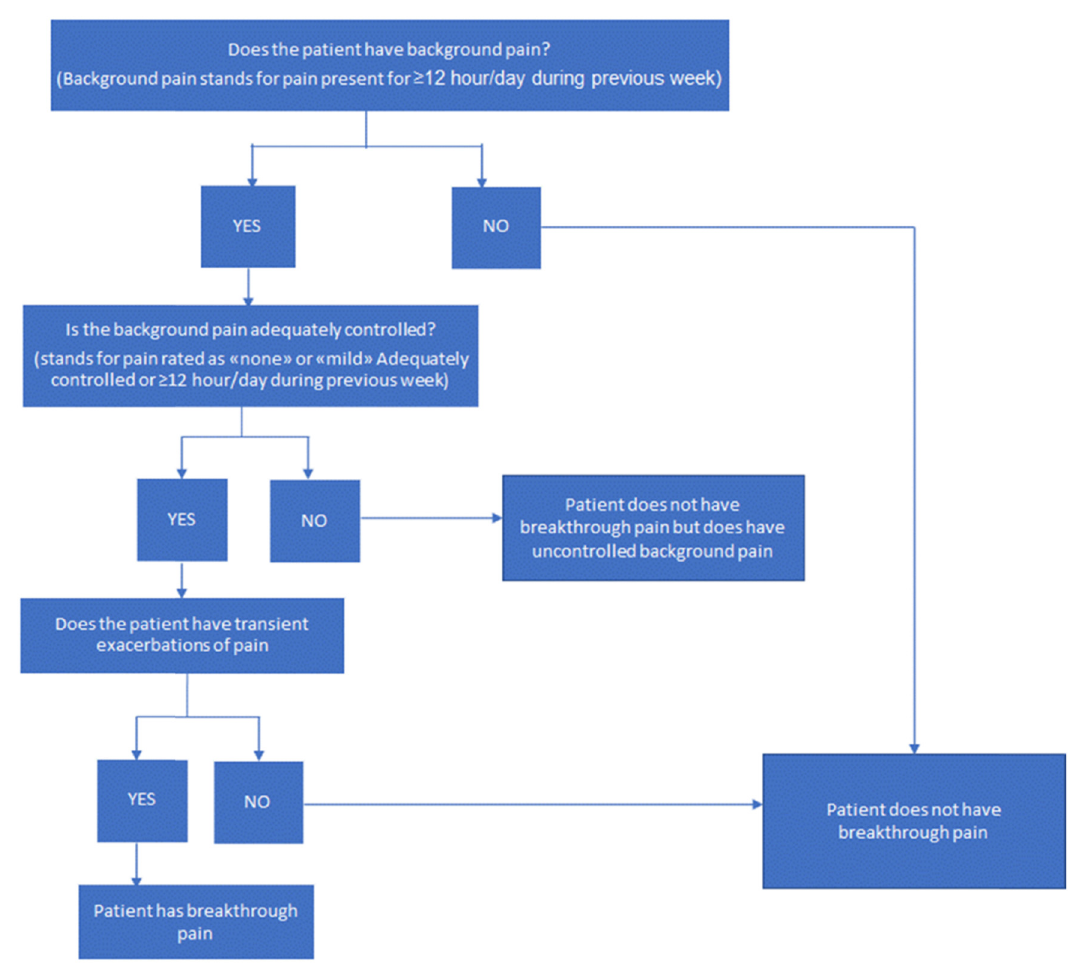
Figure 1: Davies algorithm [ 15 ]